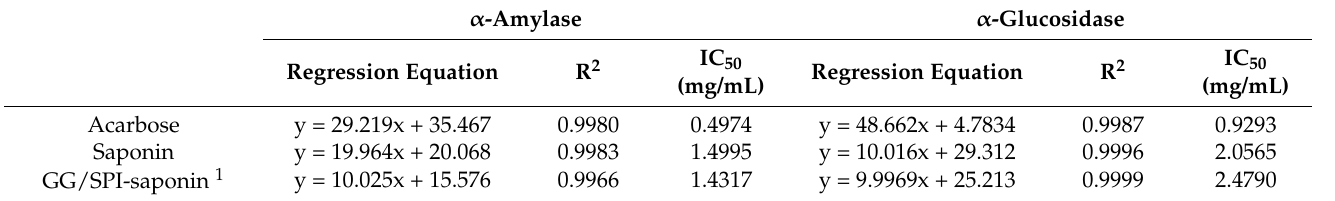
Table 3. Inhibition of α -glucosidase and α -amylase activities by acarbose, kidney tea saponin, and saponin-loaded